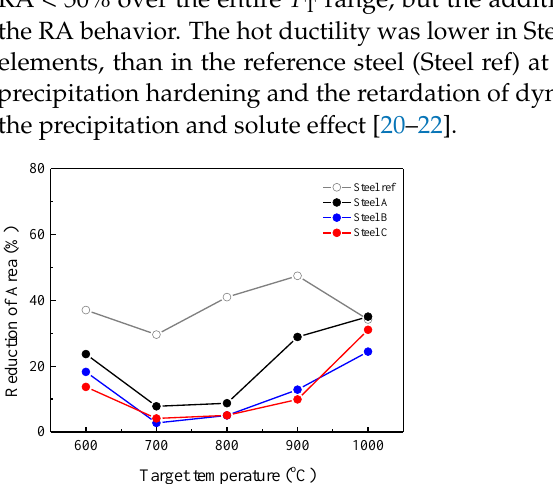
Figure 3. EBSD inverse pole figure (IPF) image of image of the specimen after hot ductility test; ( a , d ) Steel ref, ( b , e ) Steel A, and ( c , f ) Steel B at ( a – c ) T T = 800 °C and ( d – f ) T T = 900 °C. ( d-1 ) and ( e-1 ) are high magnification images of ( d ) and ( e ), respectively.